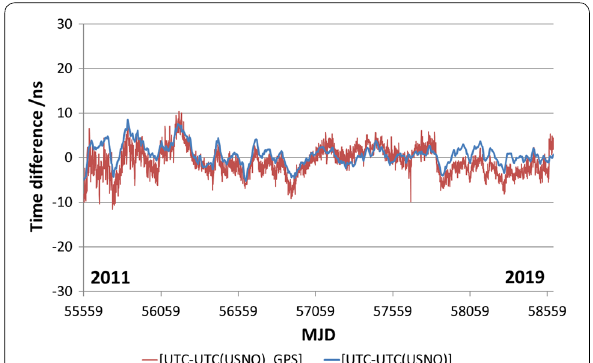
Fig. 12 Examples of the UTC(USNO) that a user can obtain from the information broadcast by GPS with respect to the UTC(USNO) estimated by the BIPM and published in Circular